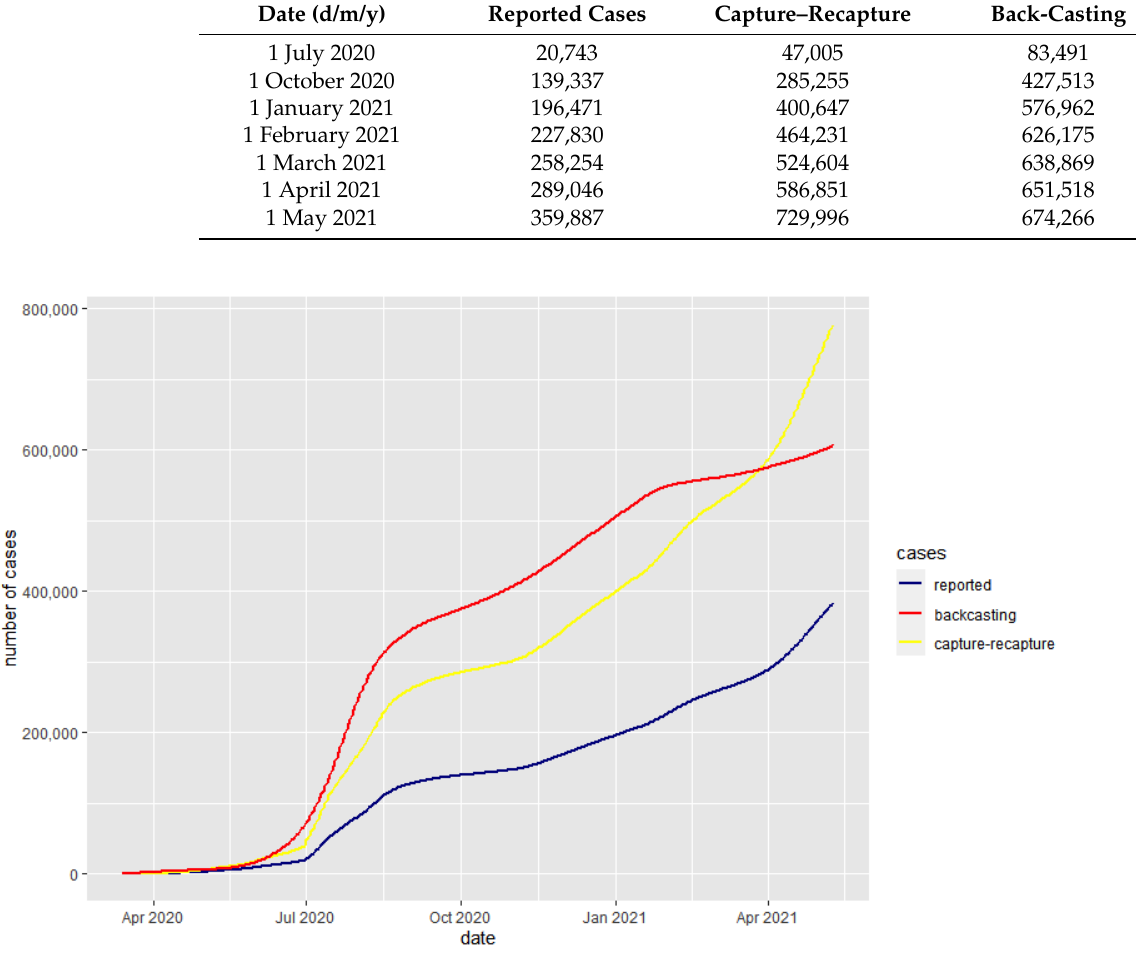
Figure 1. The cumulative number of COVID-19 cases.